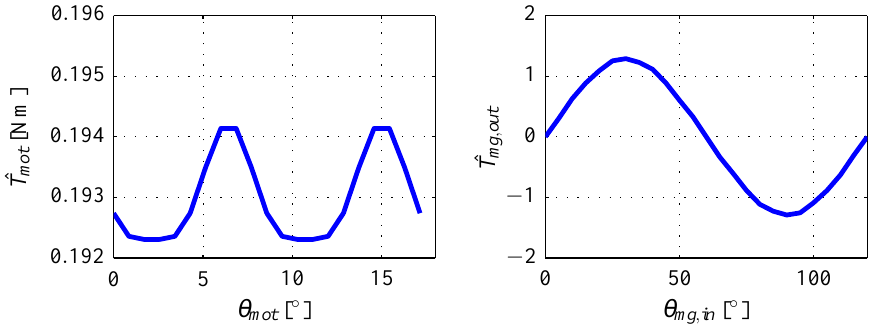
Figure 21. Optimized peak motor torque ˆ T mot and magnetic gear outer rotor torque T mg , out